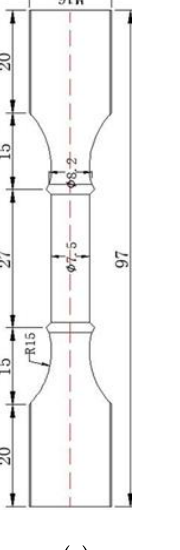
Figure 5. Uniaxial tensile test finite element numerical calculation model: ( a ) two-dimensional diagram and ( b ) three-dimensional diagram. Table 3. Performance parameters of 63Sn–37Pb tin-lead solder at a strain rate of 0.5% s − 1 .